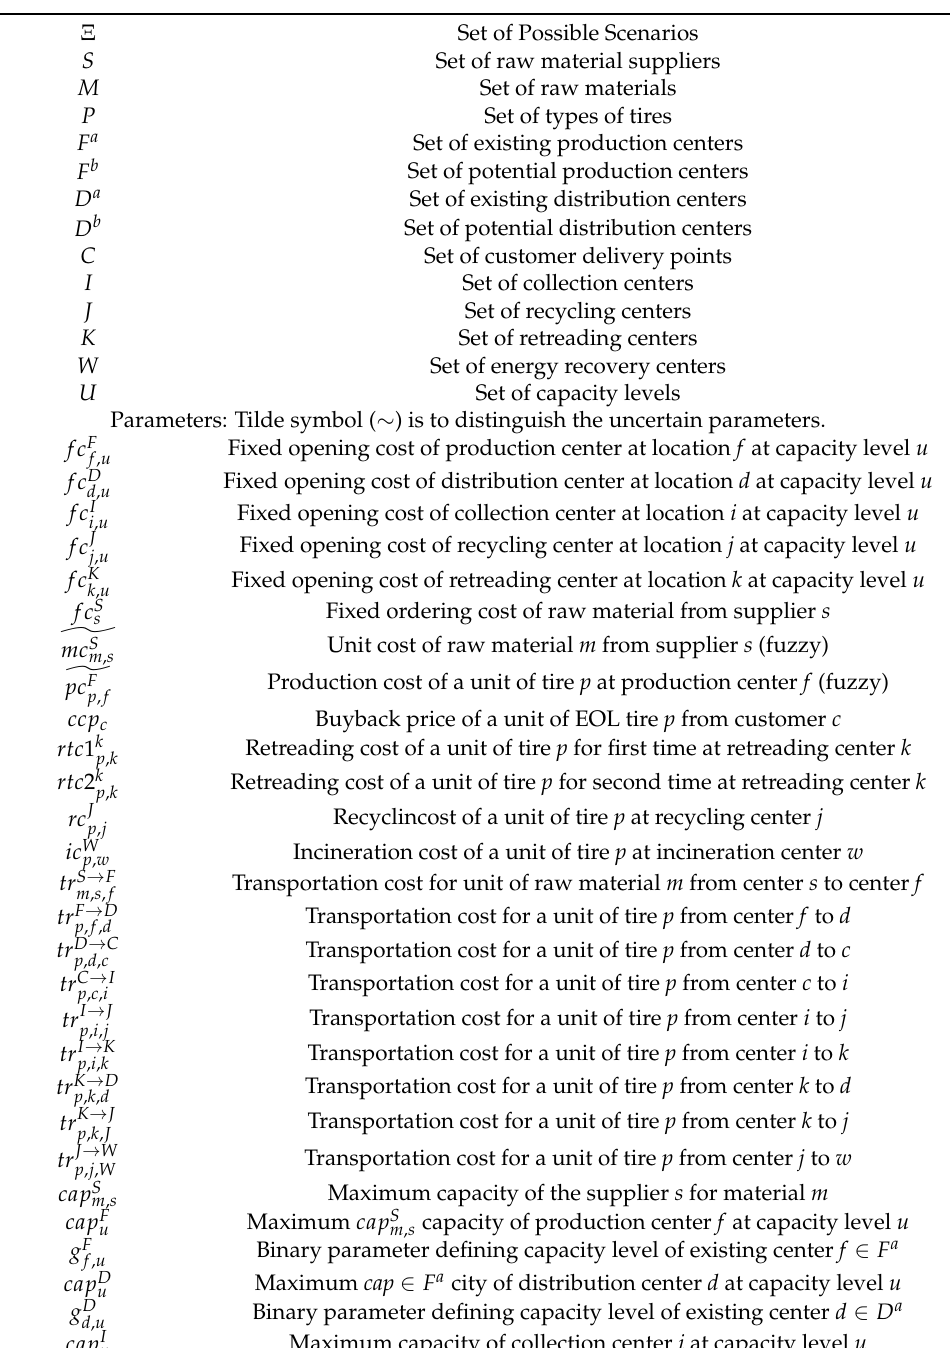
Table 2. The list of model indices, parameters and